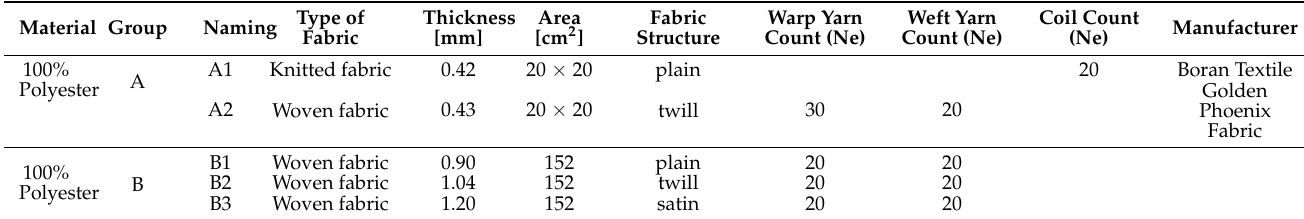
Table 1. Characteristics of the tested fabrics.